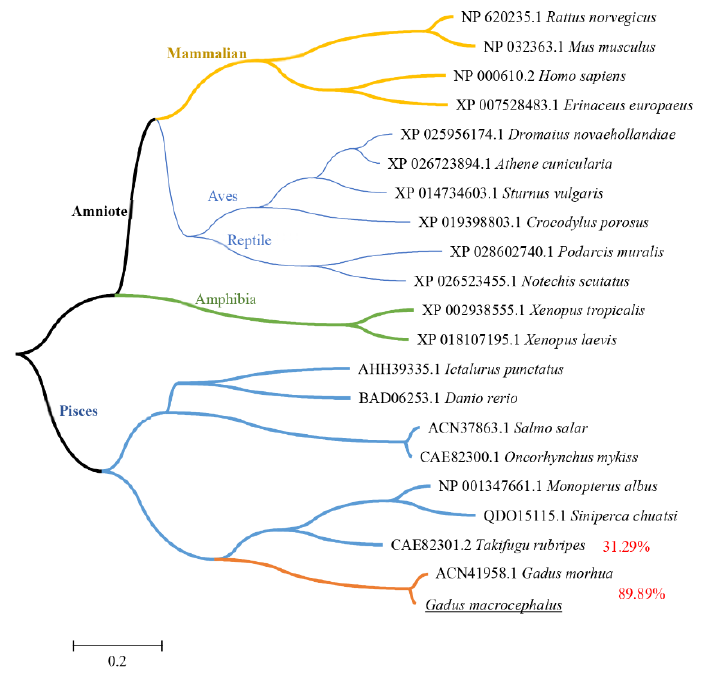
Figure 2. Phylogenetic tree of vertebrate IFN– γ peptides. The trees were computed using Neighbor-Joining method by MEGA version 5.0. Different levels of evolution were highlighted in various color.